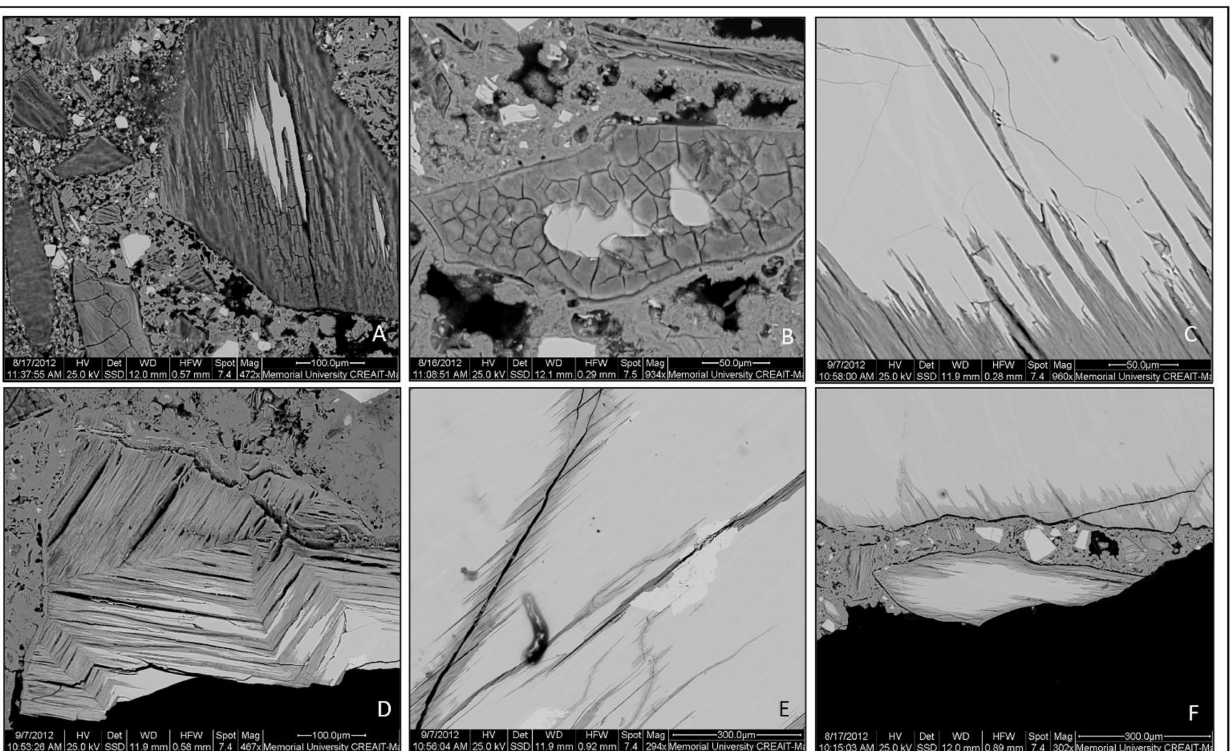
Figure 16. BSE images of coarse rejects polished grain mounts from the Reid Brook deposit, Voisey’s Bay: ( A ) intensely oxidized pyrrhotite (Po) with remnant core (white) in sample VX65901, ( B ) intensely oxidized pyrrhotite (Po) with remnant core (white) in sample VX66130, ( C ) twinned Po with oxidation along twin planes from edge inwards in sample VX60388, ( D ) intensely oxidized, kinked with oxidation along kink planes in sample VX60388, ( E ) twinned Po with oxidation along twin planes from fractures inwards, pentlandite (Pn) inclusions (white) are unaltered in sample VX60388, ( F ) Po grains cemented by iron oxide with oxidation spreading inwards from edges, Pn grains (white) in iron oxide are unaltered in sample